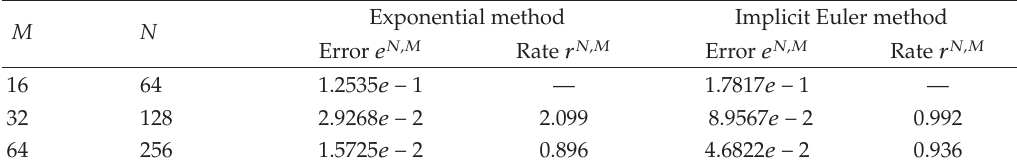
Figure 2: Computed option value U for Test 2. Table 1: Numerical results for Test